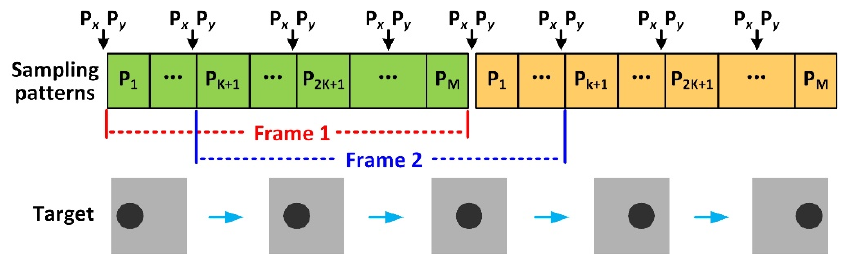
Figure 1. Schematic diagram of the sampling patterns for motion estimation and dynamic reconstruction.